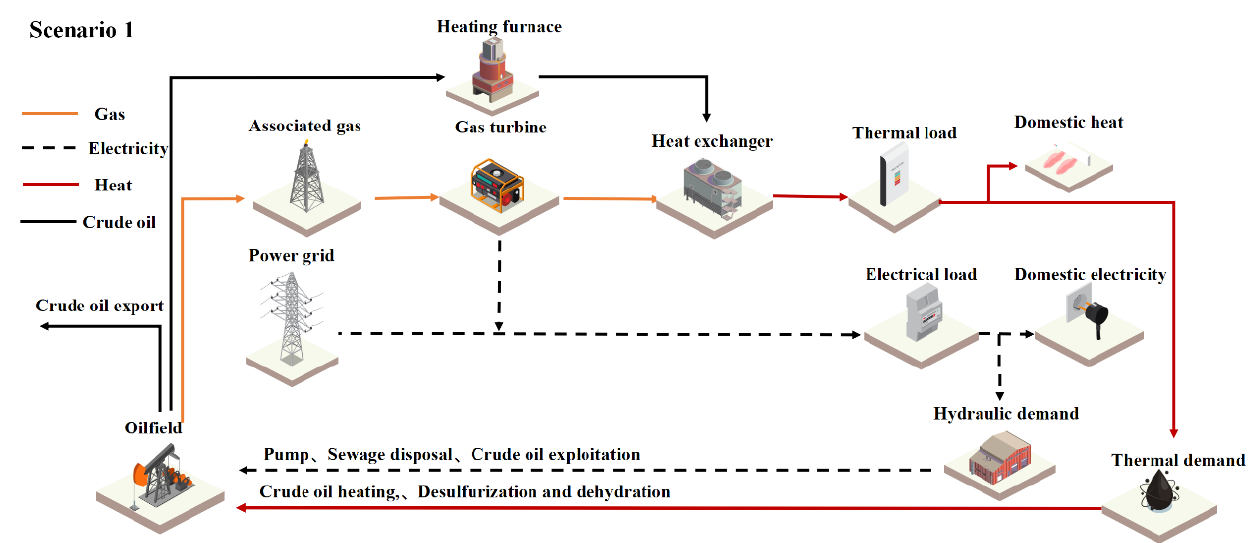
Figure 2. The oilfield energy system framework of scenario